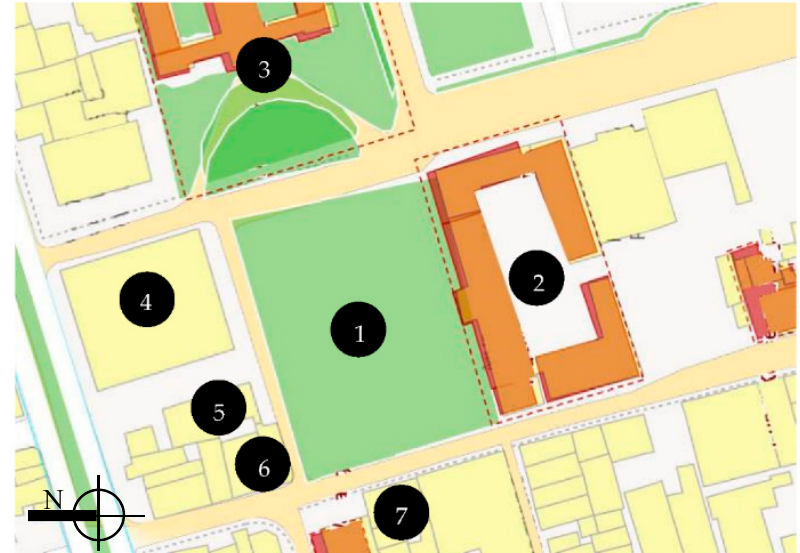
Figure 6. The area of Fatahillah Square with the surrounding heritage building. (1) The Fatahillah Square. (2) Jakarta History Museum. (3) Museum of Fine Arts and Ceramics. (4) Post Office. (5) Jasindo Building. (6) Café Batavia. (7) Wayang Museum. Source: Collection of Jakarta Satu, 2020.